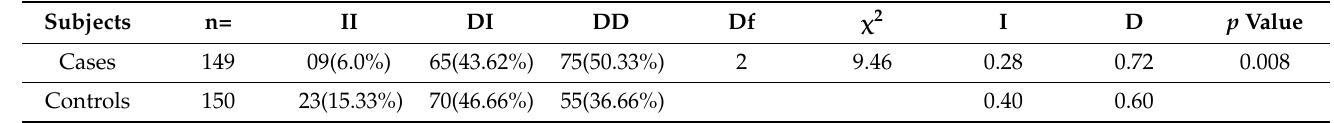
Table 3. Clinical association of ACE2 I/D gene variation between coronary artery disease cases and